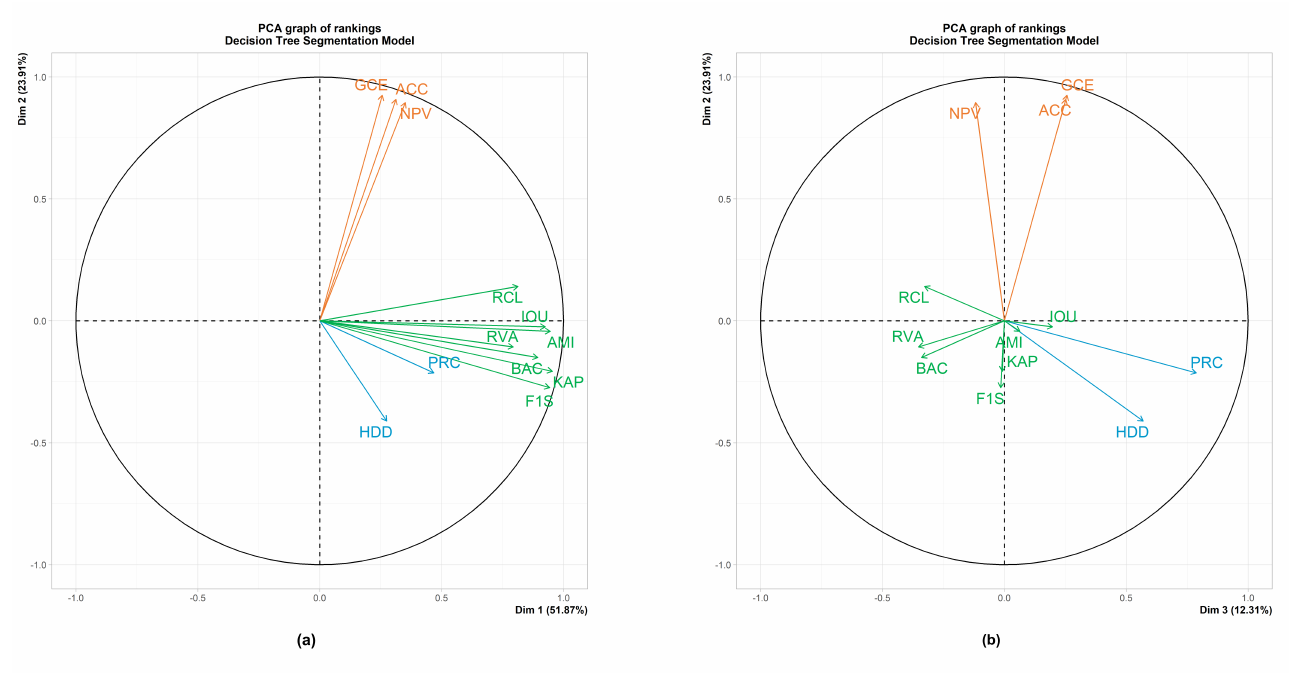
Figure 5. Projections of the metrics on the planes formed by: ( a ) 1st and 2nd PCs; ( b ) 3rd and 2nd PCs. However, the orange and blue groups are clearly uncorrelated along the second